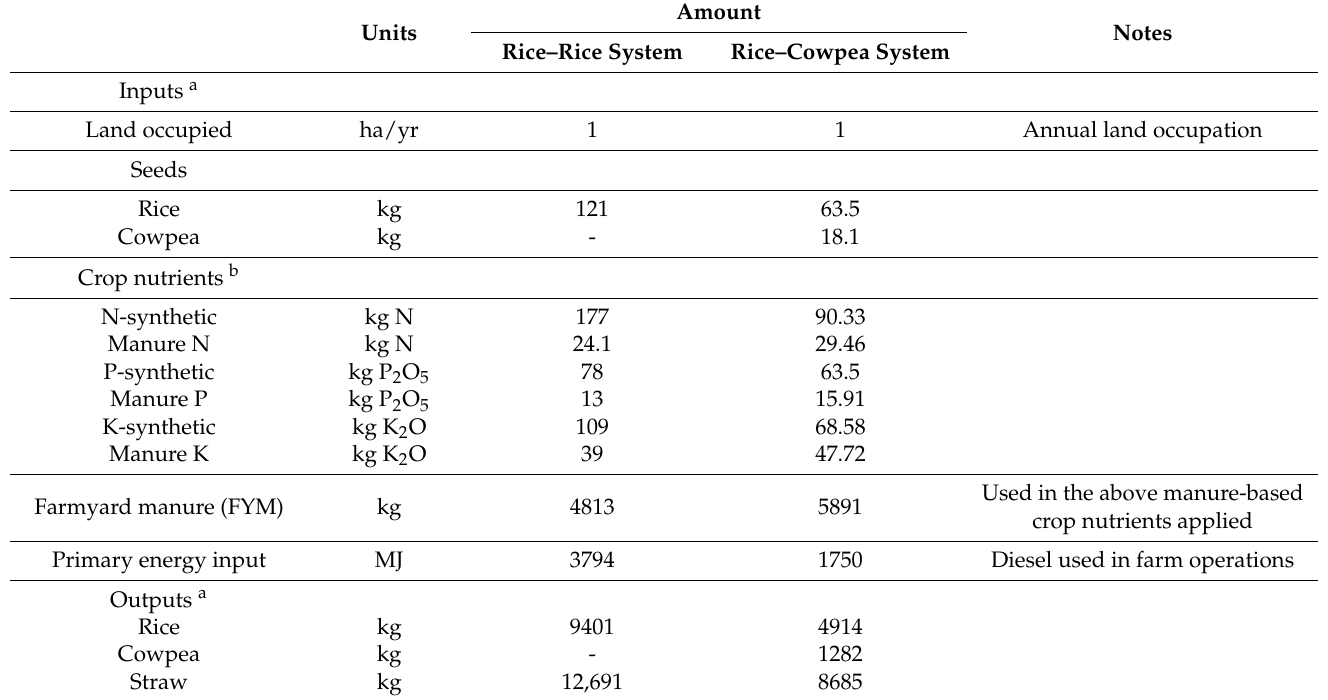
Table 1. LCI for the crop production systems. Values are weighted average (yield based) calculated from the selected farms (30 for each of the two cropping